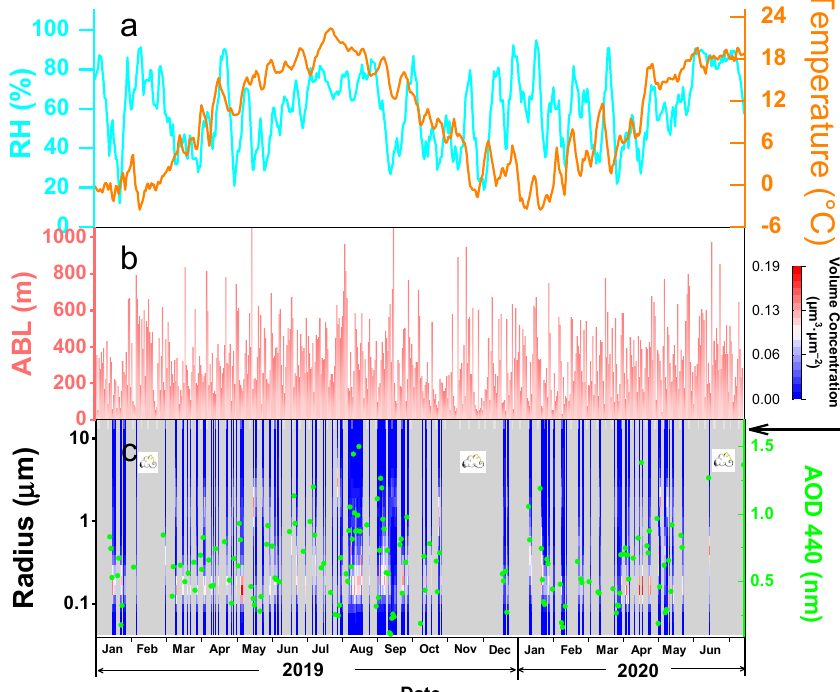
Figure 1. Daily variation in meteorological parameters, including relative humidity (RH) and temperature at 850 hPa ( a ), atmospheric boundary layer height (ABL) ( b ), and columnar volume size distribution (VSD) ( c ). The gray are in ( c ) denotes days without AOP inversions due to unfavorable observation conditions (e.g., cloudy, rainy). The daily parameters used here are the daily average composites of raw observations. AOD variation is also shown in ( c ). Note that double y -axes are employed in ( a , c ).